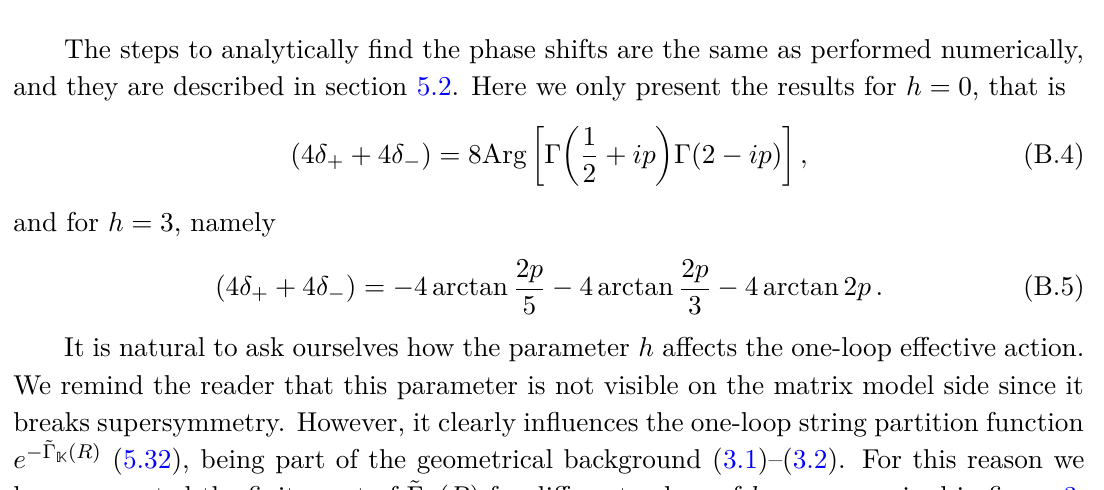
Figure 3 . The regularized one-loop effective function ˜Γ K ( R ) − log(Λ e − R ) (5.32) for different values of h , integers and